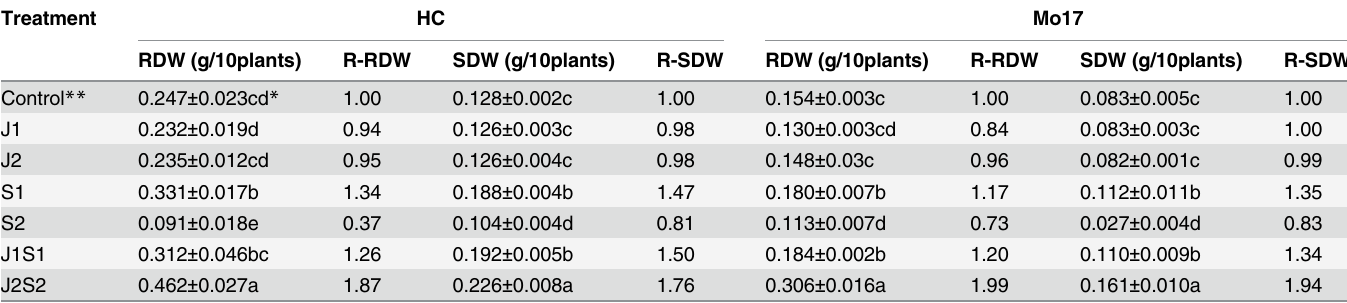
Table 4. Effect of coating agent on maize root dry weight and shoot dry weight under chilling stress.